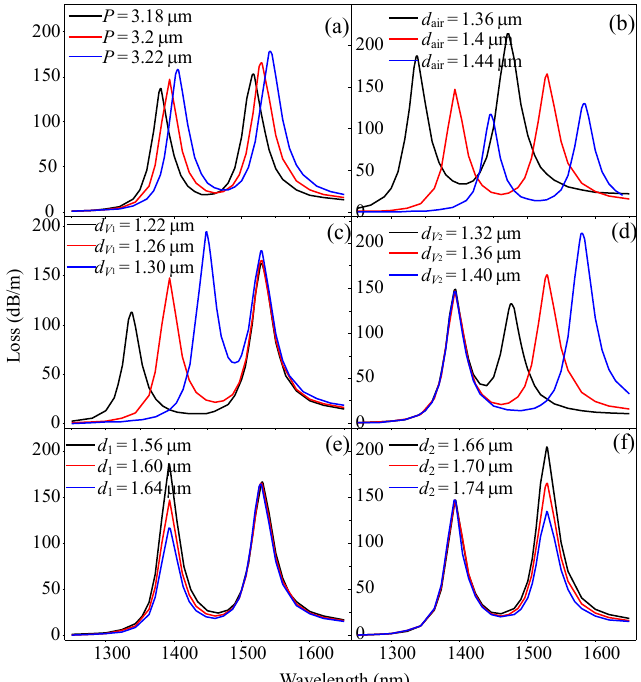
Fig. 6 Loss spectra of the core mode with different values of (a) P , (b) d air , (c)